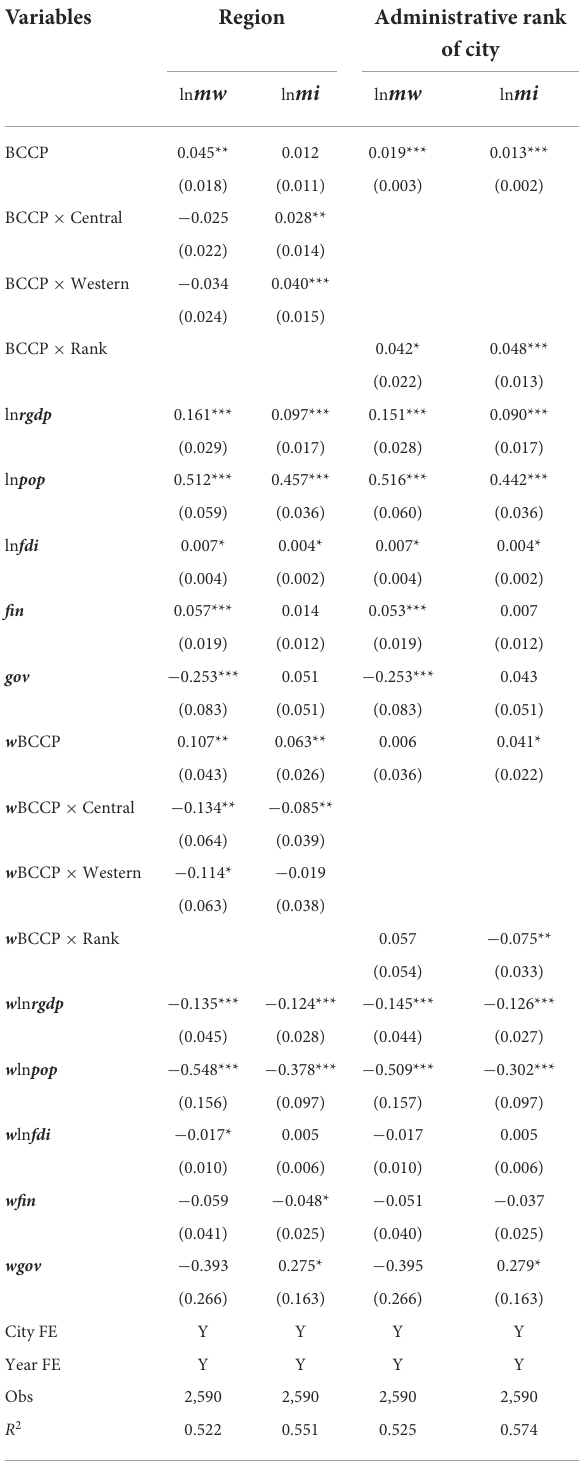
TABLE 7 Heterogeneity